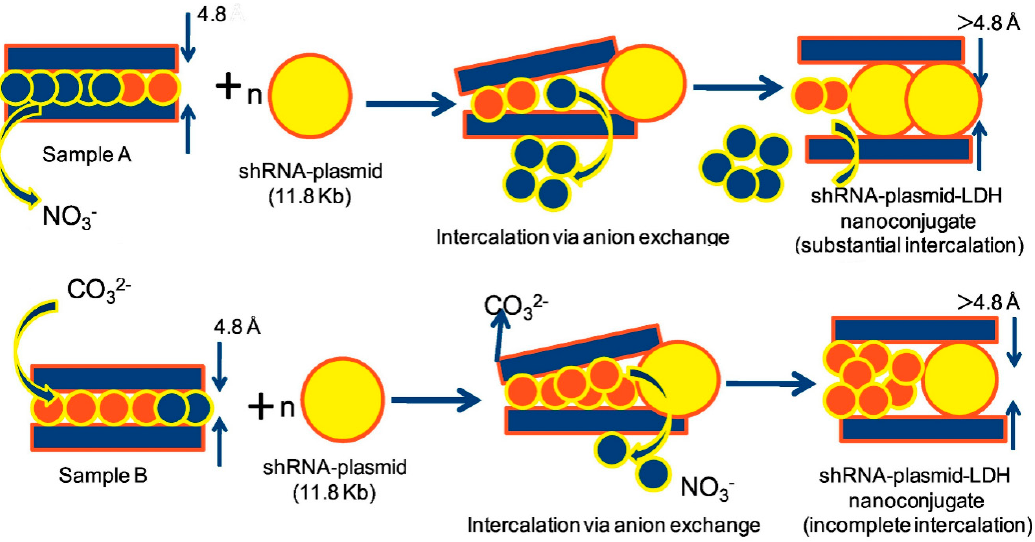
Figure 13. Schematic representation of the mechanism of intercalation of anionic shRNA-plasmid, in presence of NO 3 − / CO 32– , in cationic layers of samples A (precipitated at pH 8.5) and B (precipitated at pH 12.5). Reprinted from Ref. [194], Copyright (2019), with permission from Elsevier.